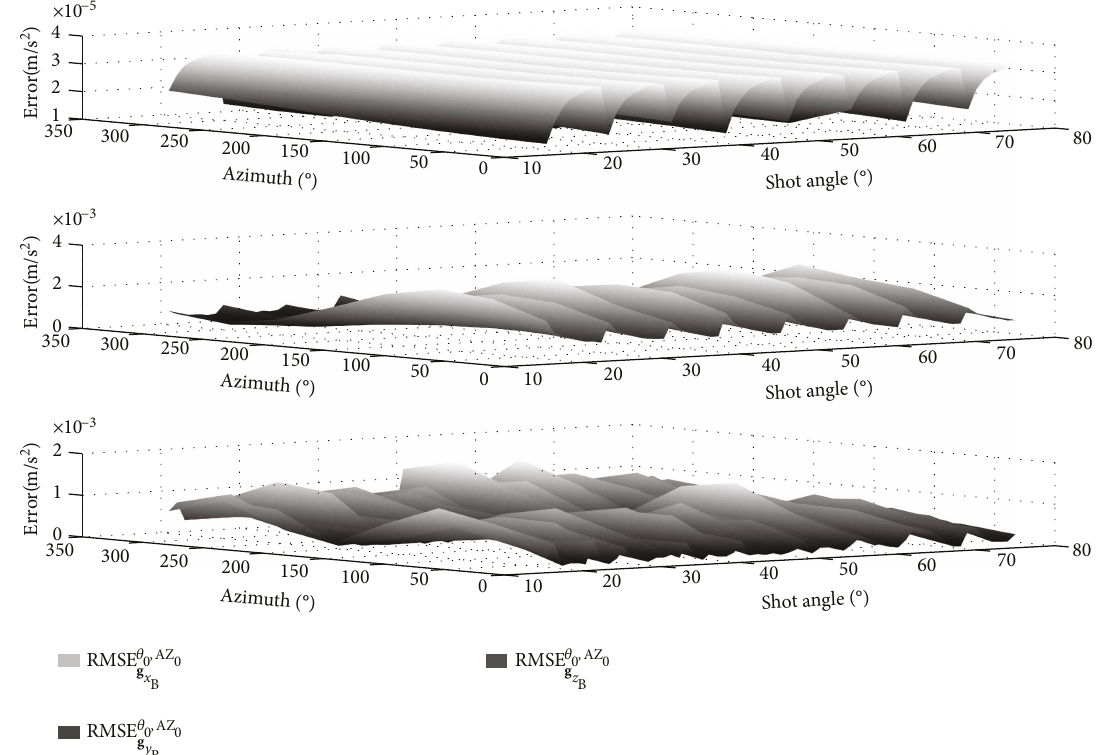
Figure 6: Representation of gravity vector RMSE along the whole trajectory for each shot angle and for the 8 azimuths tested.